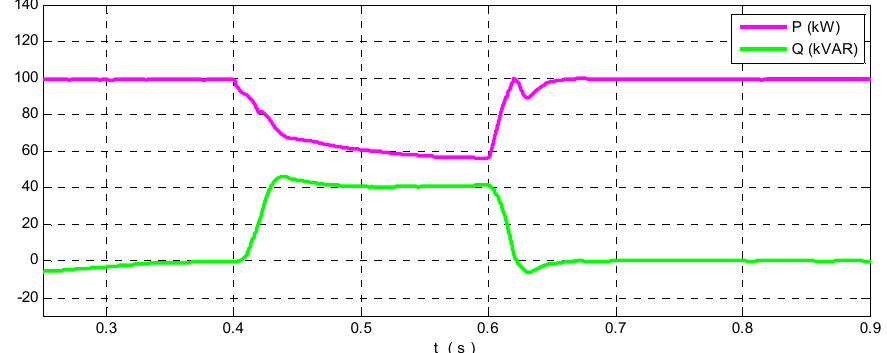
Figure 9. The active and reactive power fed to the grid .